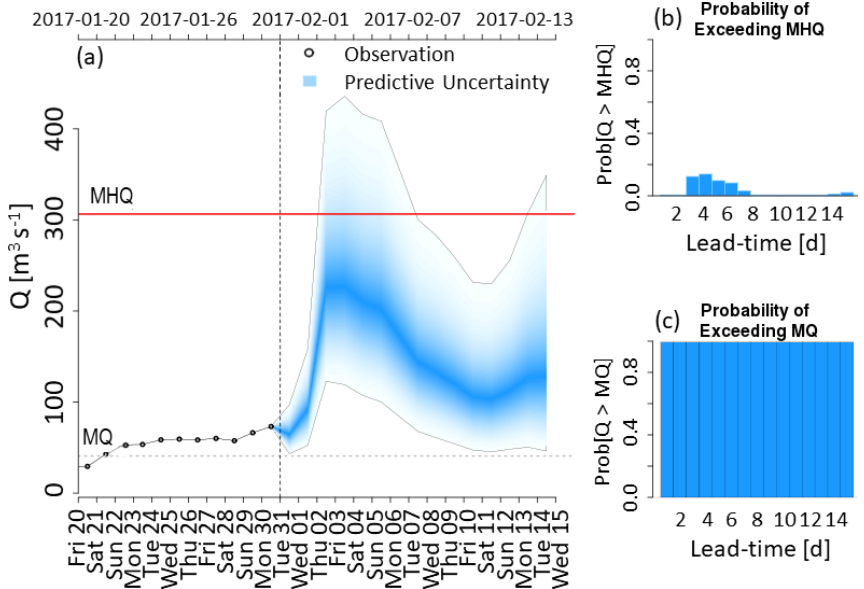
Figure 4. Example of the real-time hydrograph product for the station in Brehy, Slovakia, on 31 January 2017. (a) Probability distribution of the post-processed forecast. The darkest shade of blue indicates the forecast median (50th percentile), with each consecutive shade indicating a percentile difference such that the extent of the total predictive uncertainty is shown by the shaded region. Solid grey lines indicate the upper (99th percentile) and lower (1st percentile) bounds of the forecast probability distribution. The red line shows the mean annual maximum (MHQ) threshold, and the dashed grey line shows the mean flow (MQ) threshold. Black circles represent observations positioned at the centre of the timestep over which they are calculated. (b) Bar chart showing the probability of the discharge exceeding the MHQ threshold at each lead time. (c) Bar chart showing the probability of the discharge exceeding the MQ threshold at each lead